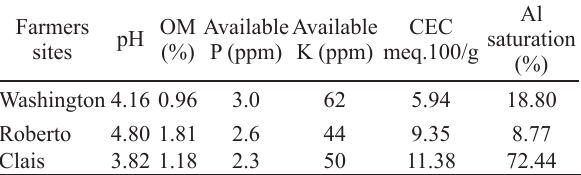
Table 1. Initial level of soil nutrients at 0 - 15 cm depth in the three farmers sites under overgrazing pastures in Santo Tomas, Yurimaguas.